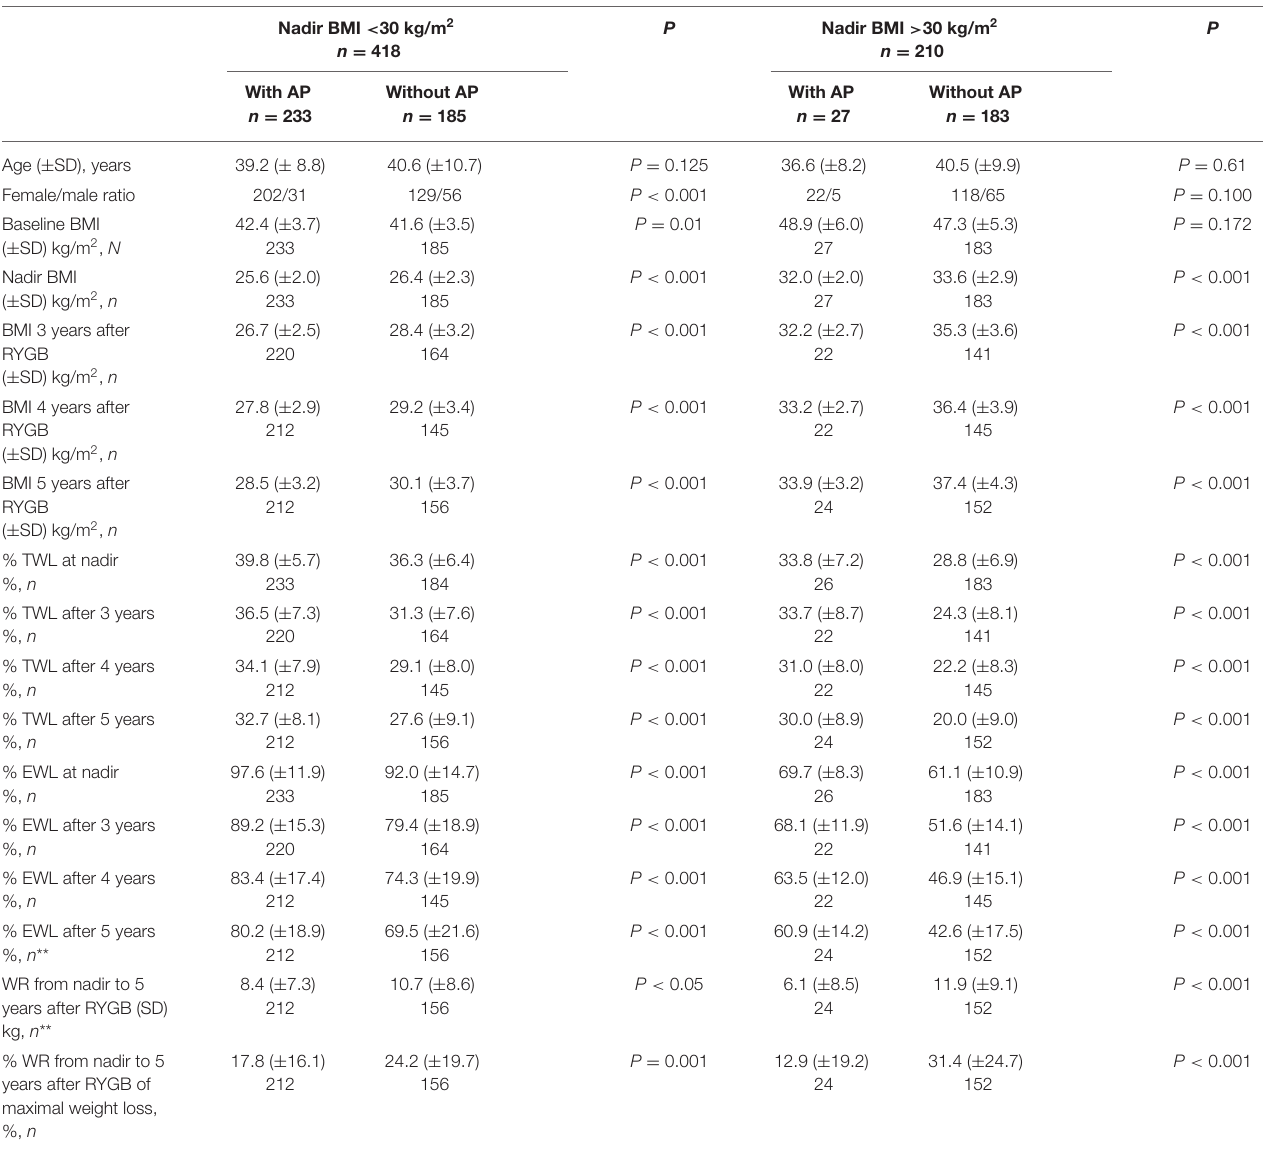
TABLE 2 | Patients’ characteristics and weight